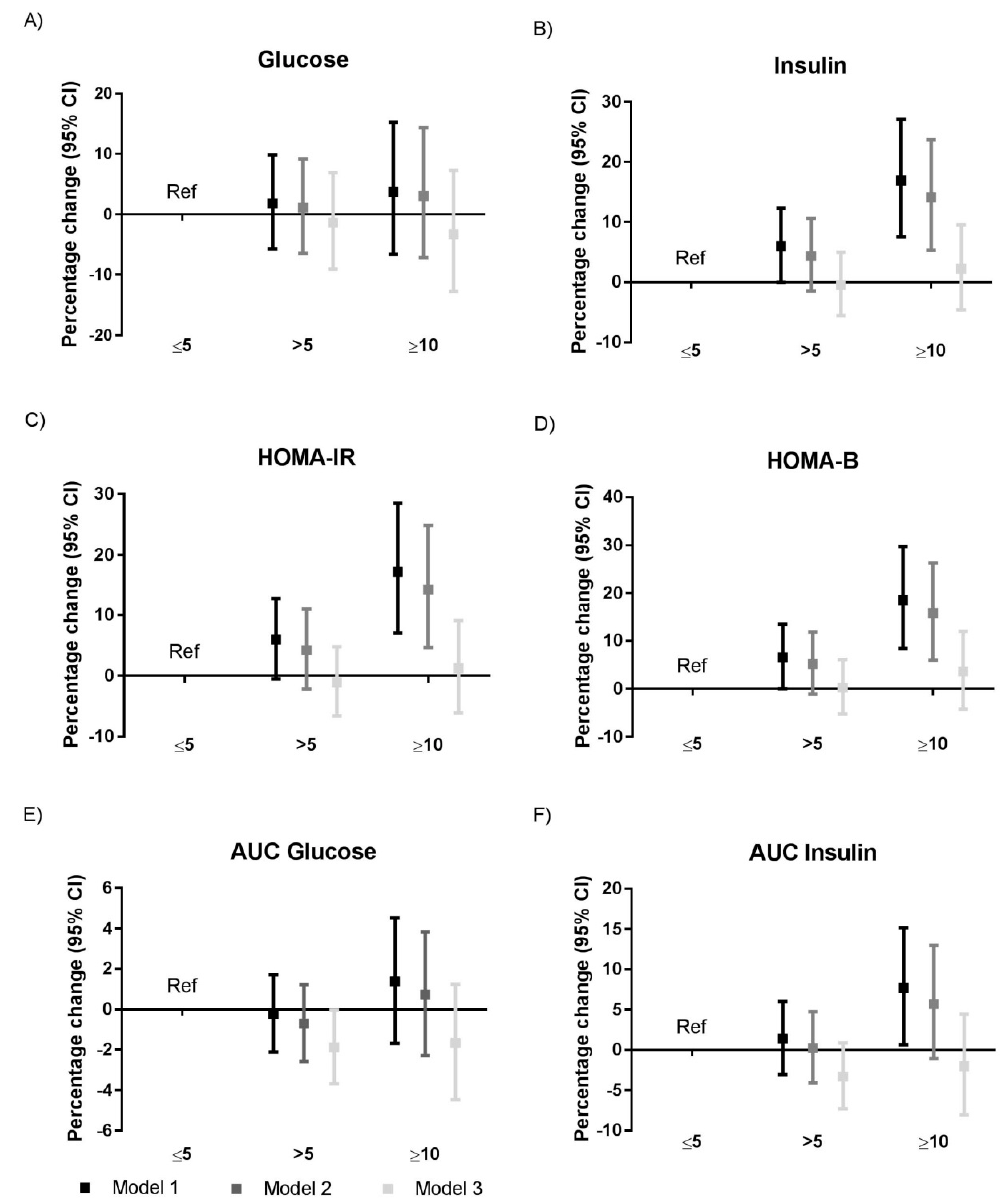
Figure 2. Associations between sleep quality and ( A ) fasting glucose, ( B ) fasting insulin, ( C ) HOMA-IR, ( D ) HOMA- β , ( E ) AUC of glucose, and ( F ) AUC of insulin. Results were based on analyses weighted towards the BMI distribution of the general Dutch population ( n = 4672) and were derived from regression coe ffi cients with 95% confidence intervals from linear regression analyses, using either a group with a PSQI total score of > 5 or ≥ 10, and expressed as percentage change in outcome measure, as compared to the good sleep group as reference category. Model 1: Adjusted for age and sex; Model 2: Adjusted for age, sex, ethnicity, education level, smoking, alcohol intake, caloric intake, and physical activity; Model 3: Adjusted for Model 2 + risk of sleep apnea and BMI. Abbreviations: AUC, area under the curve; CI, confidence interval; HOMA-IR, homeostatic model of insulin resistance; HOMA- β , homeostatic model of β cell function; Ref, reference category. n = 4511 for the analyses with AUC glucose and n = 4586 for the analyses with AUC